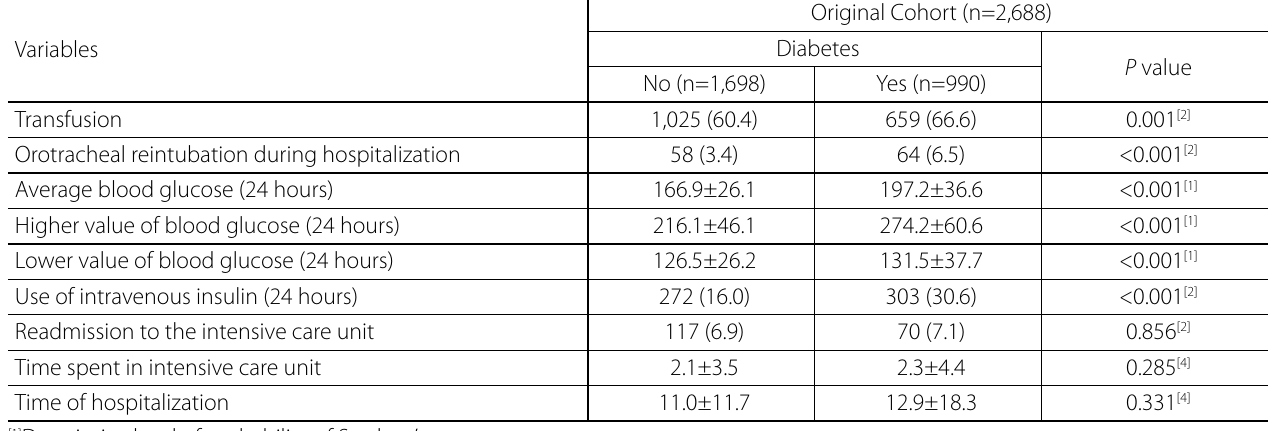
Table 4. Descriptive values [average ± standard deviation or n (%)] of postoperative variables according to the study group. Variables